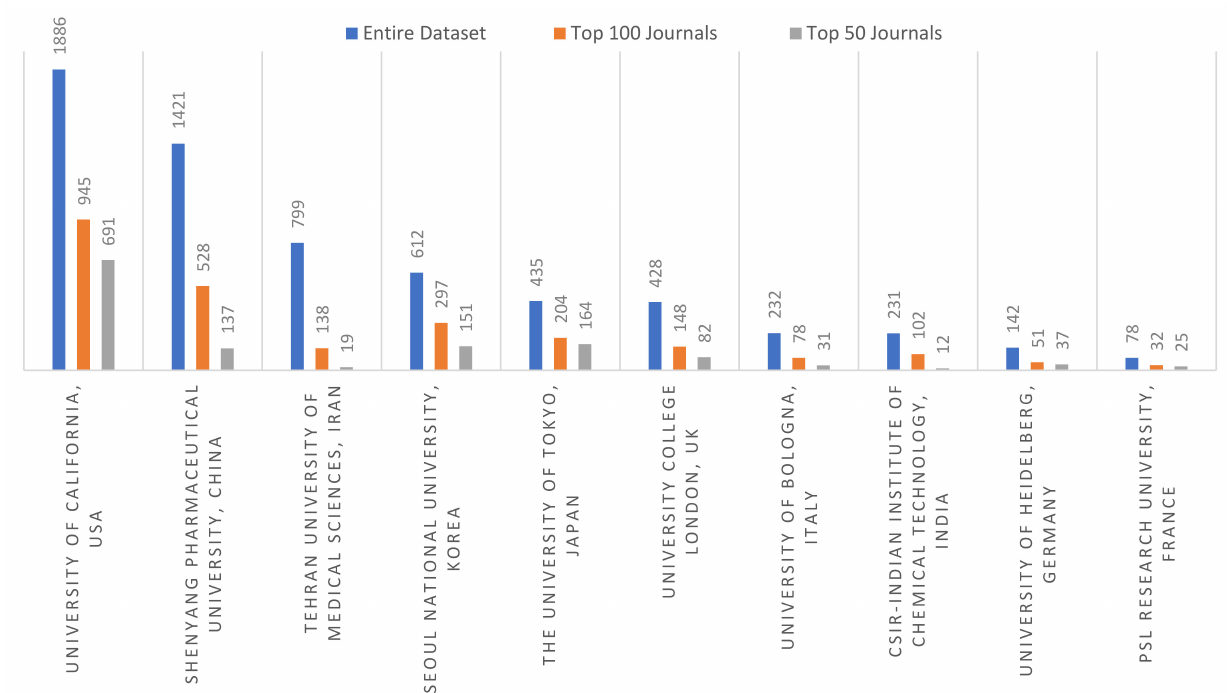
Figure 8. Main affiliations of authors publishing in the area of cancer